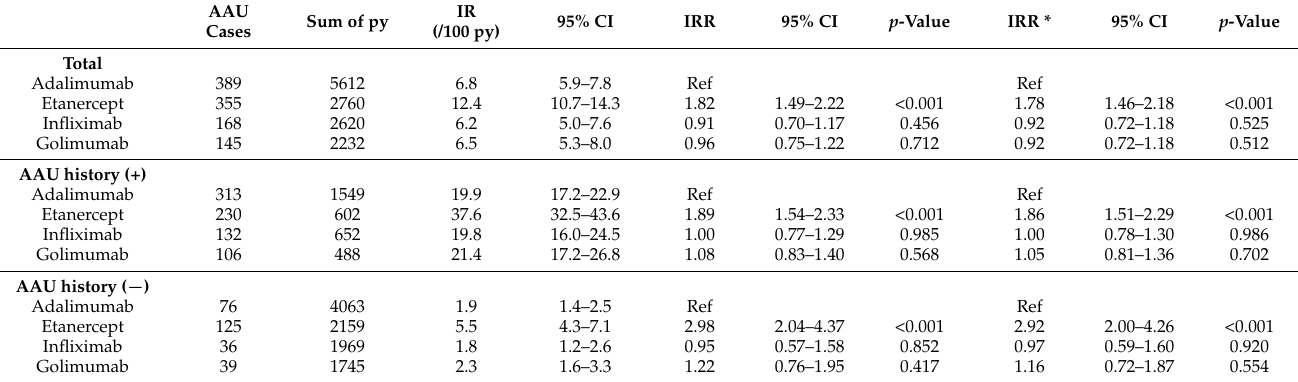
Table 4. The risk of occurrence of total AAU events within 2 years of initiation of each TNF- α